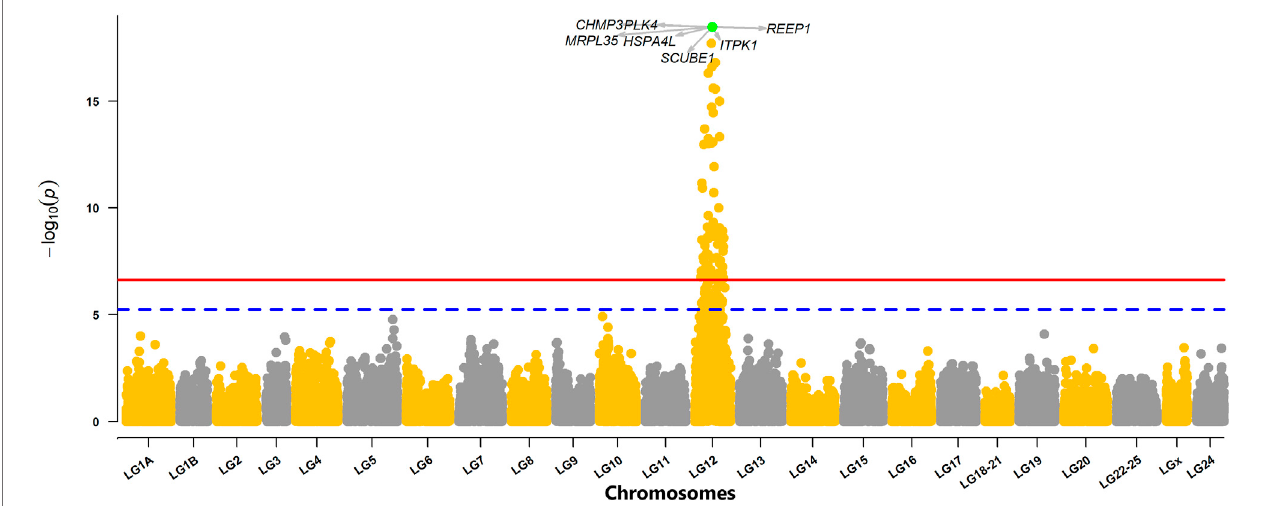
FIGURE 2 | Manhattan plot with the distribution of − log 10 ( p ) values of SNPs across different chromosomes. The solid red line represents the genome-wide Bonferroni-correctedthreshold,whilethedashedbluelineisthechromosome-wideBonferroni-correctedthreshold.Thegreenhighlightedpointisthehighestsigni fi cant SNP of GWAS analysis, and the arrows are depicting underlying genes within the ±25 Kb region from the position of the highest signi fi cant SNP.